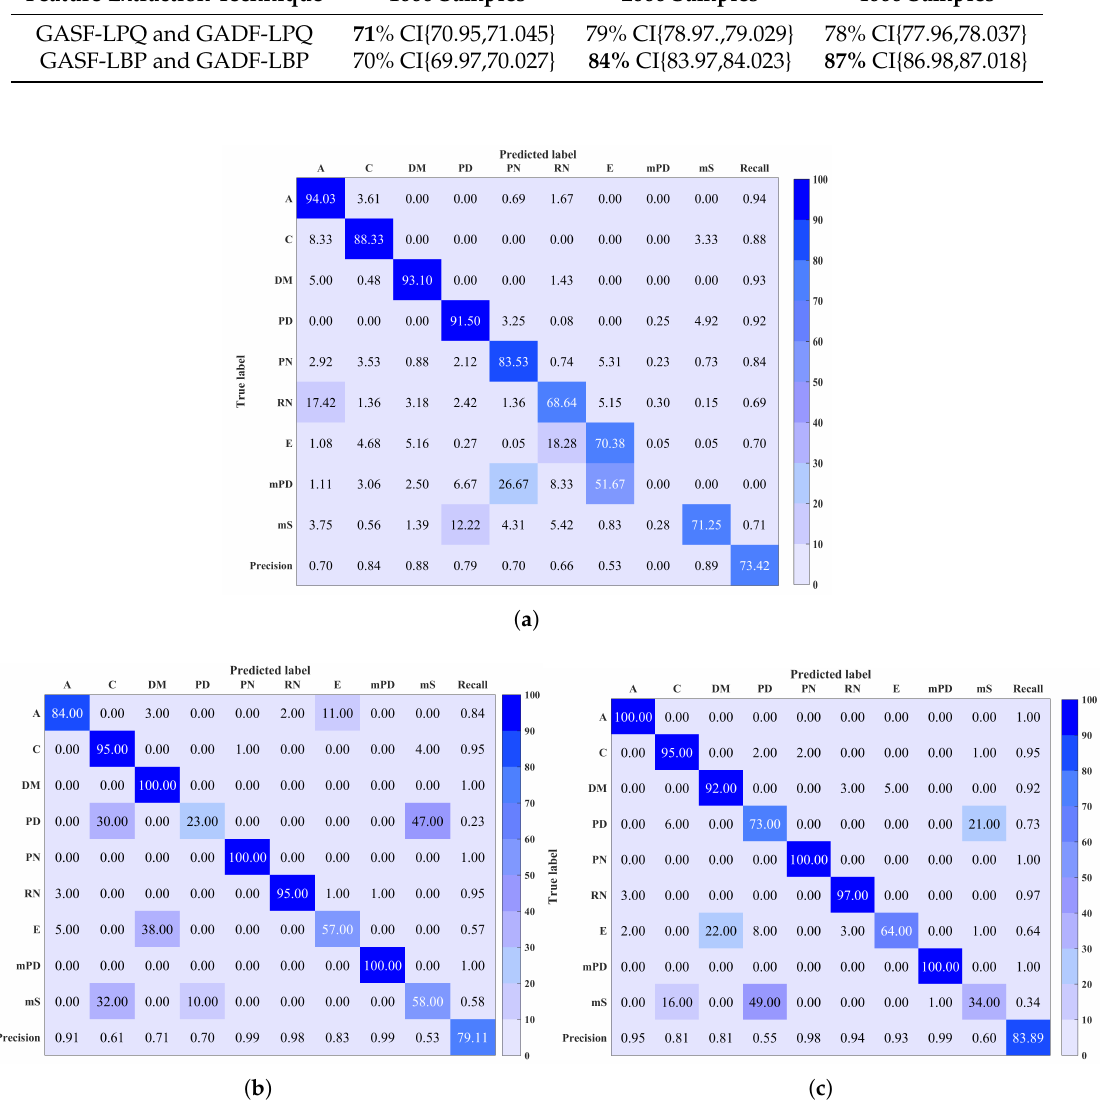
Figure 8. Confusion matrix resulting from ( a ) ALIF-entropy features, ( b ) Gramian Angular Field (GAF) combined with LPQ, and ( c ) GAF combined with LBP. Overall classification accuracy is shown in the bottom right